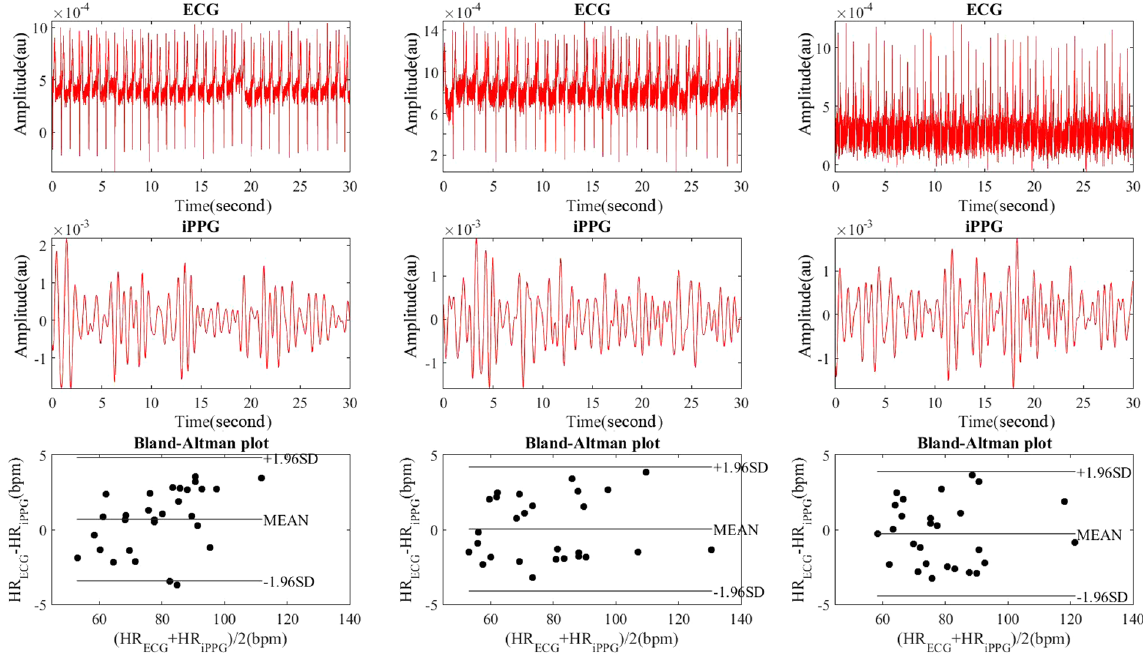
Figure 2. Heart-rate cues and Bland-Altman plots in an initial experiment with three subjects, one per column.